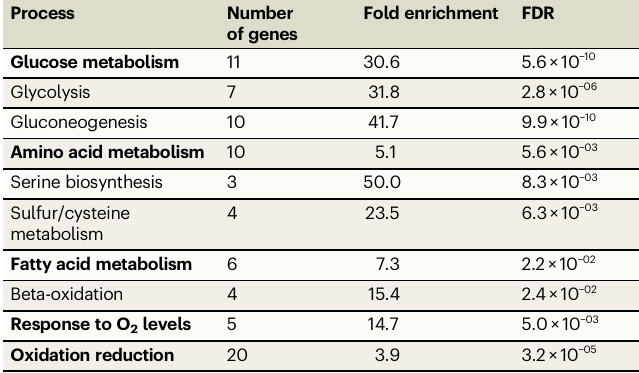
Table 1 | Gene ontology of 216 targets directly upregulated by HIF-1